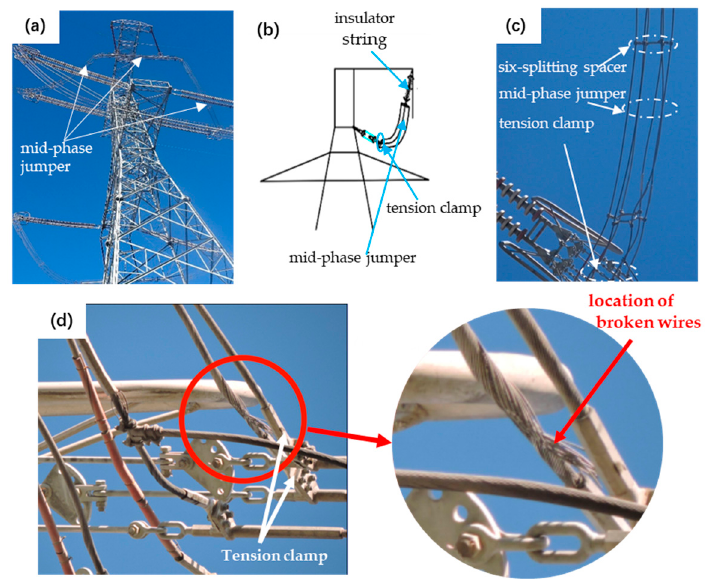
Figure 1. ( a ) Position of a mid-phase jumper on a tension tower, ( b ) lateral view of a mid-phase jumper on a tension tower, ( c ) movement of a mid-phase jumper near a tensile clamp, and ( d ) position of broken strands on the site of a mid-phase jumper.